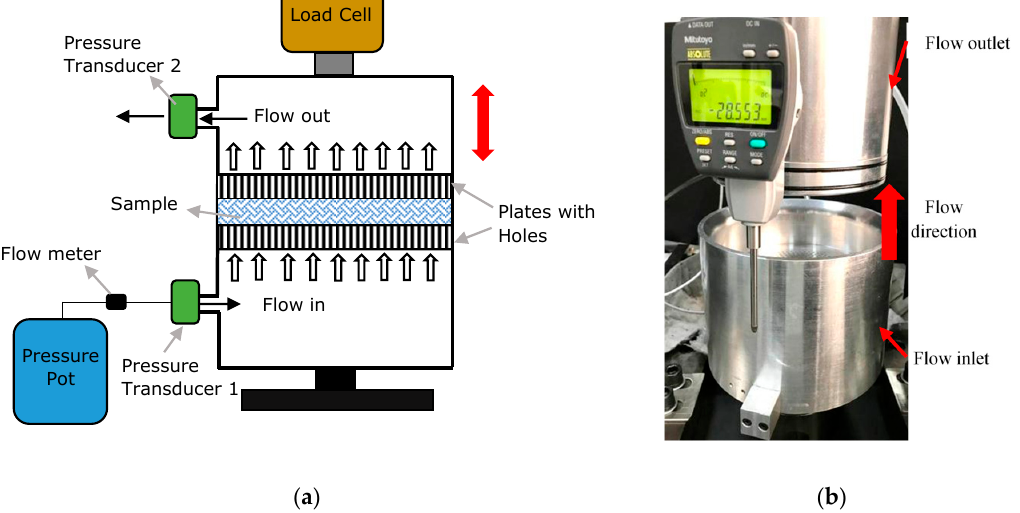
Figure 3. ( a ) Schematic diagram of Transverse Permeability Fixture; and ( b ) photograph of the fixture.